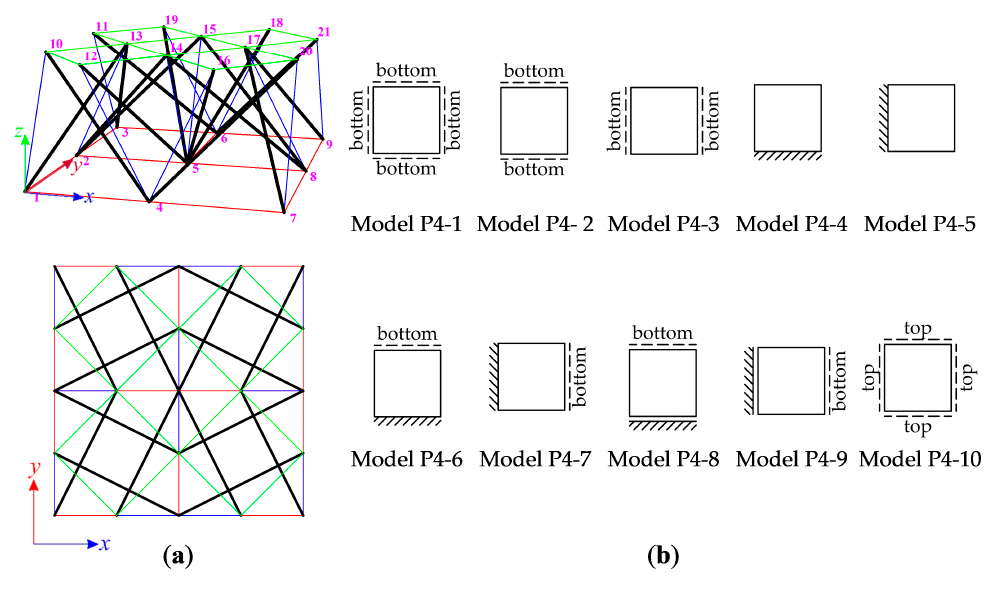
Figure 9. Four-module tensegrity plate-like structure: ( a ) geometry, ( b ) models— bottom means that lower nodes 1–4 and 6–9 are supported; top means that upper nodes 10–12, 14–16 and 18–21 are